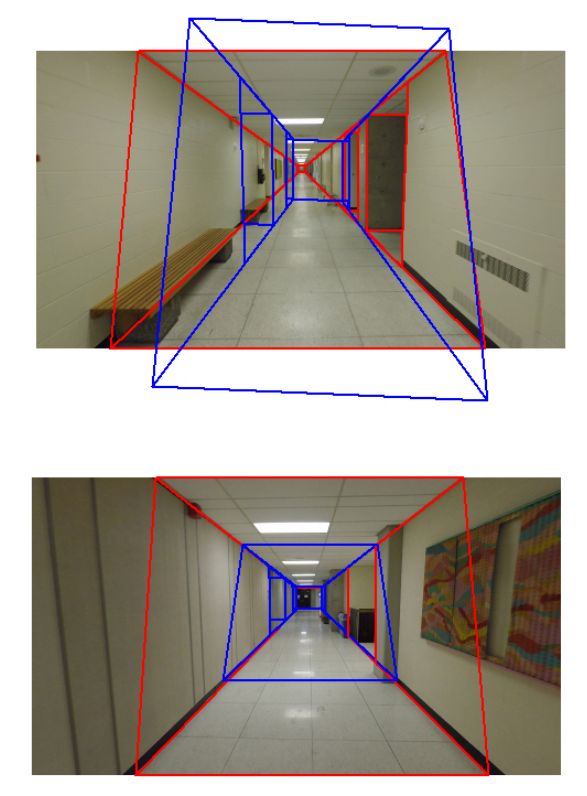
Figure 6. Test layout models (blue lines) and key layout models (red lines) are back projected into the key model’s images.